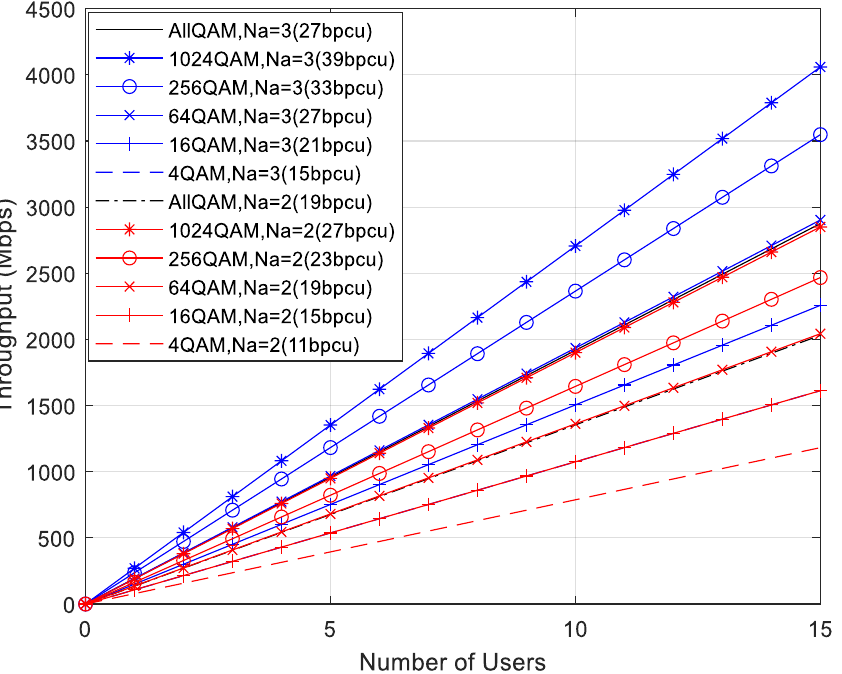
Figure 10. Average throughput vs number of users for N sc = 256, N tx = 17 antennas / user and N rx = 16 antennas / user with perfect channel estimation.